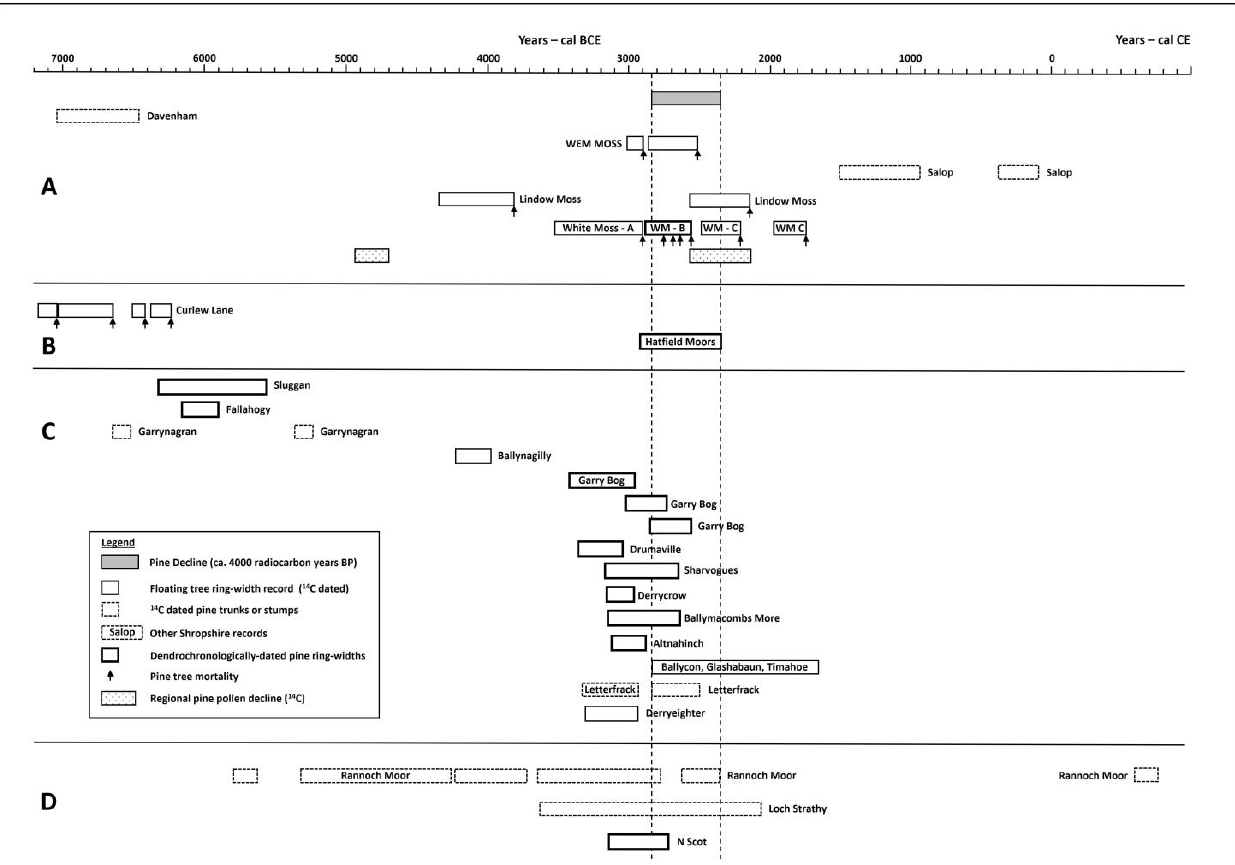
Figure 7. The ‘classic’ date often linked to the Pine Decline of 4000 14 C years BP or ca. 2835 – 2346 cal. BCE [36] and the relative dating of P. sylvestris macro- and microfossils from ( A ) Shropshire (Salop) and Cheshire — the Meres and Mosses region, ( B ) Lancashire and south Humberside, ( C ) Ireland and ( D ) Scotland — N Scot refers to 11 sites providing dendrochronologically dated records from Moir et al. [69] (Dating sources: [10,16,25,53,61,62,63,64,67,68,69,71,76,81,82,87, Drumaville — D. Brown pers. comm., Wem Moss — this paper). 14 C dating at Curlew Lane, Wem, Lindow and White